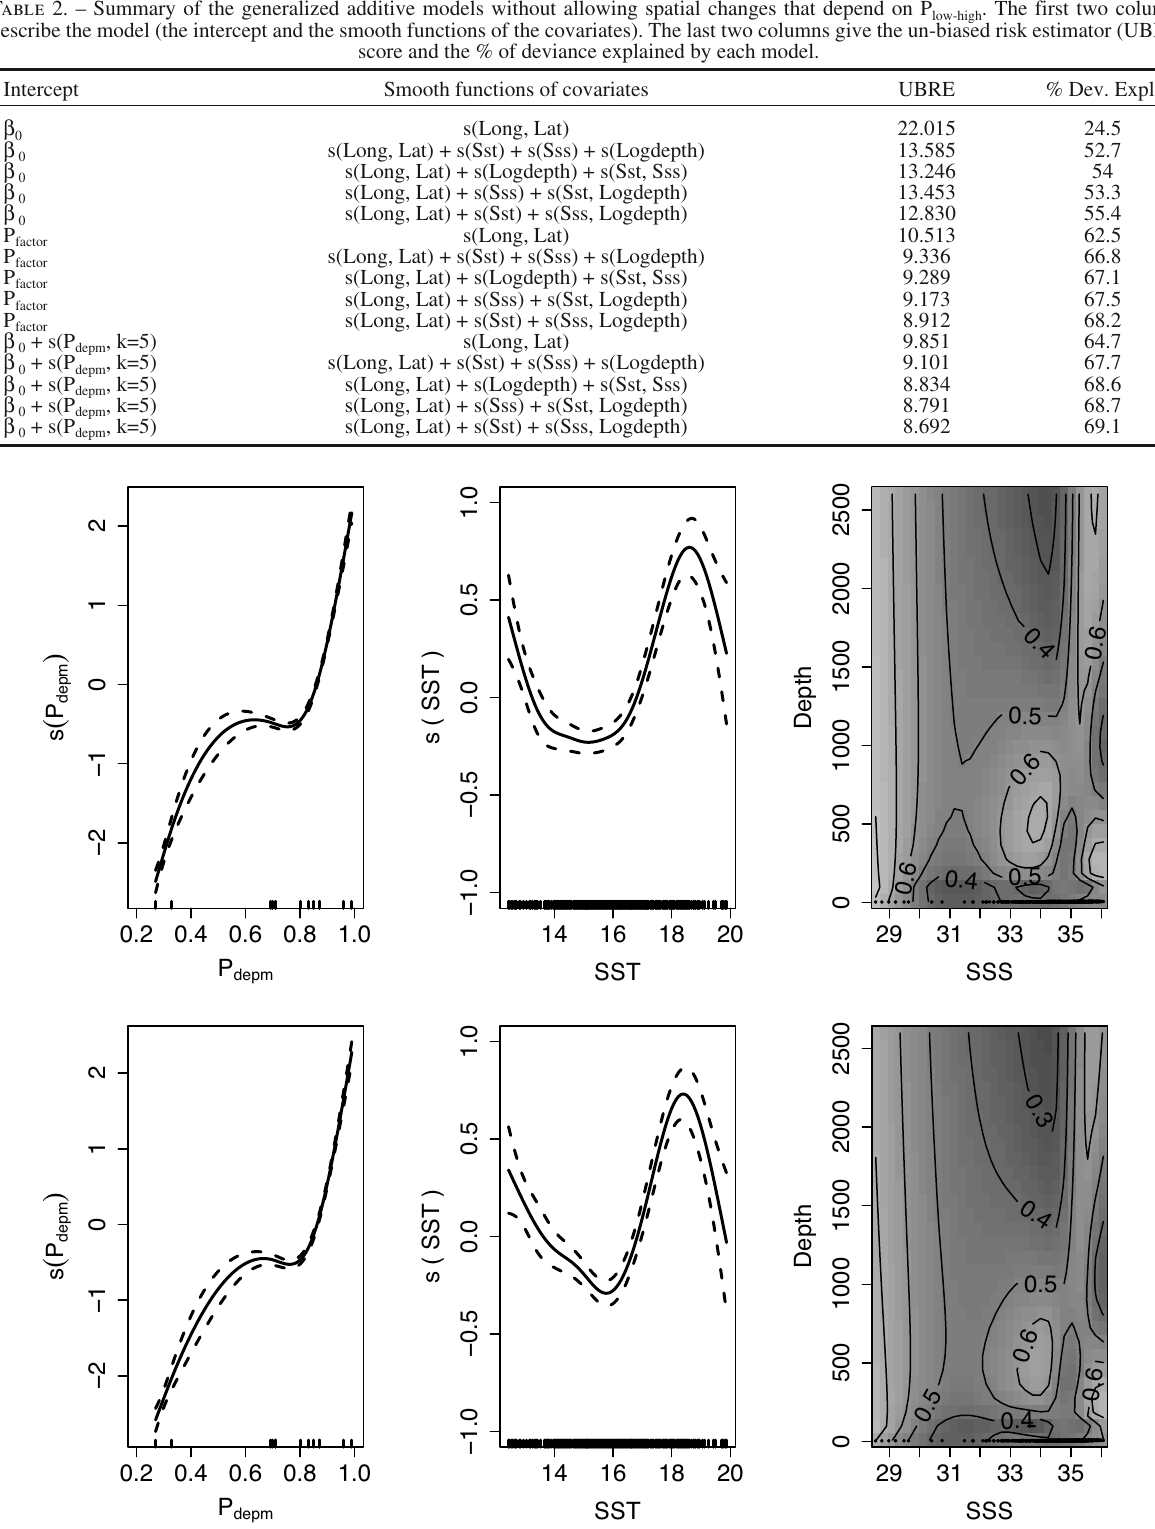
Fig . 4. – Smooth functions of the best model in terms of un-biased risk estimator score when the bivariate geographical smooth function of longitude and latitude is independent (top row) and dependent (bottom row) on whether the overall age-1 proportion is low or high (P From left to right the univariate smooth function of P , the univariate smooth function of sea surface temperature (SST) and the contour depm lines of the bivariate smooth of sea surface salinity (SSS) and depth are